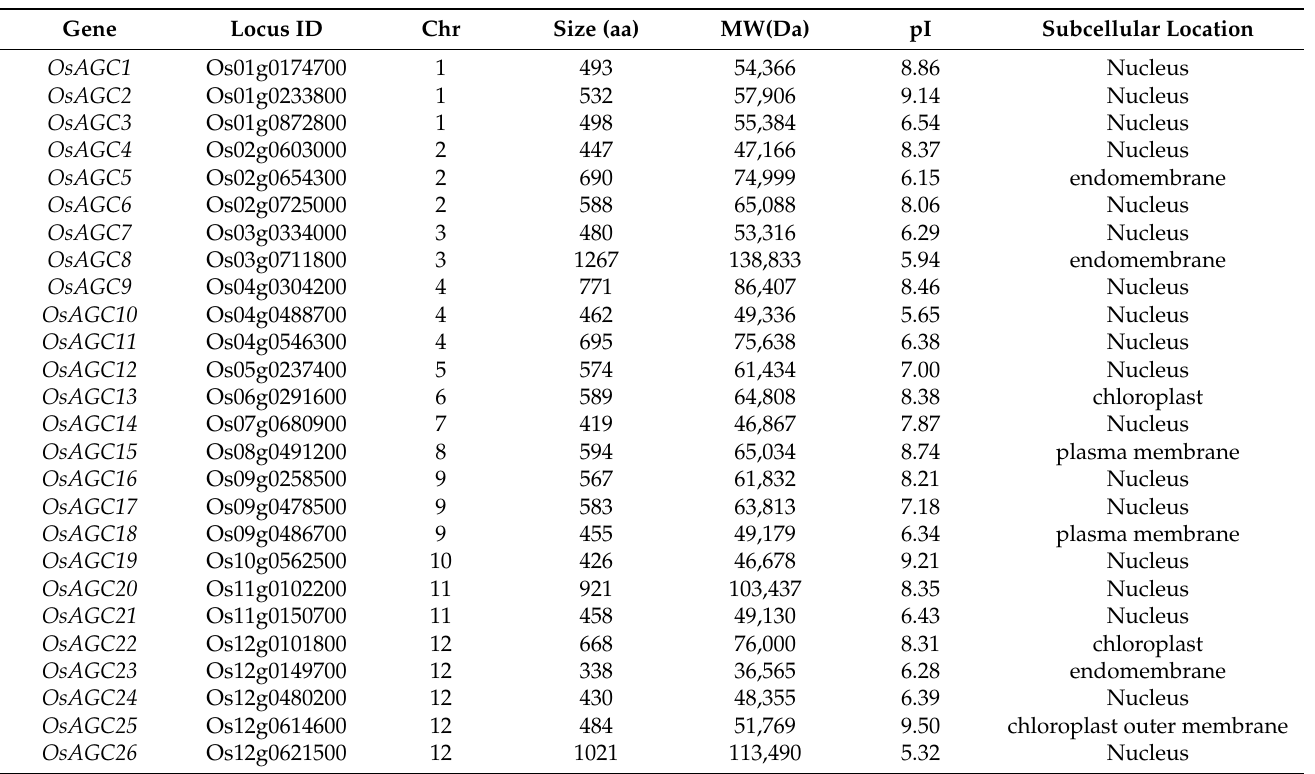
Table 1. Basic information of OsAGC family genes and their proteins in O. sativa , japonica .